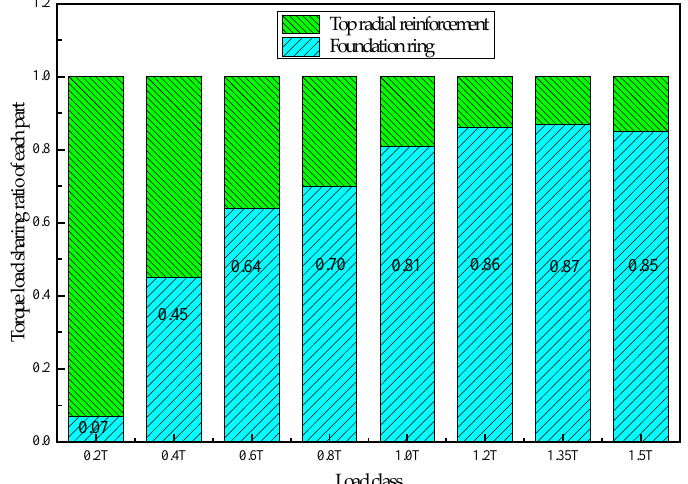
Figure 11. Torque load sharing ratios of ZT-2.